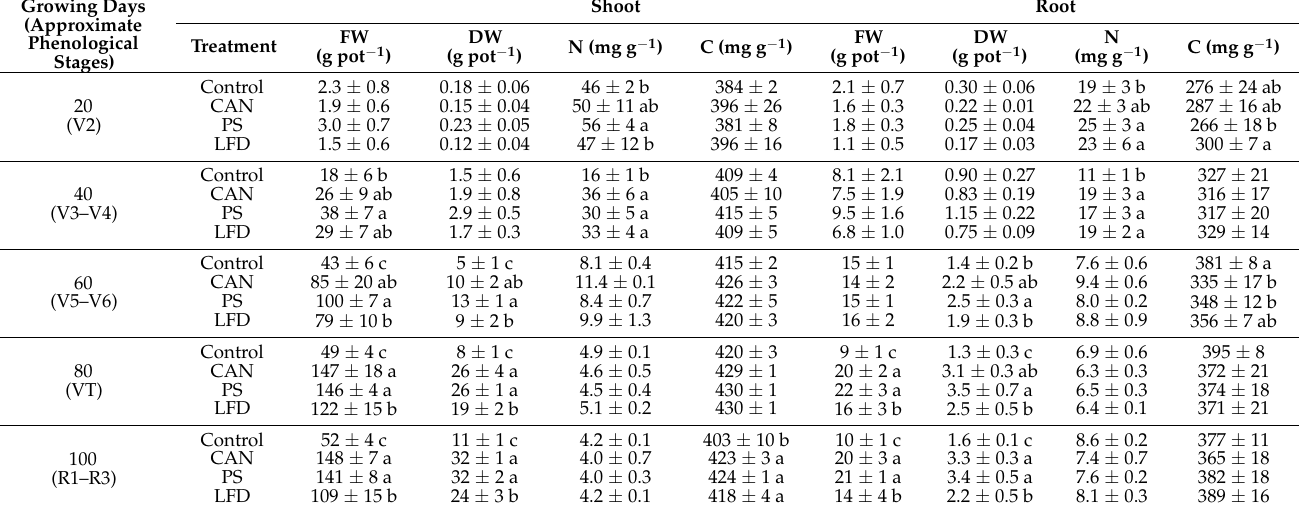
Table 2. Fresh weight (FW), dry weight (DW), and the C assimilation and N uptake of the maize shoots and roots on DW basis (mean ± standard deviation; n = 4). The small letters refer to statistical analyses for each sampling date using one-way ANOVA and post-hoc pair-wise comparisons with a significant difference at the 5% level. Parameters without letter assigned showed no significant difference between treatments. Control = no N fertilizer; CAN = calcium ammonium nitrate, PS = pig slurry, LFD = liquid fraction of